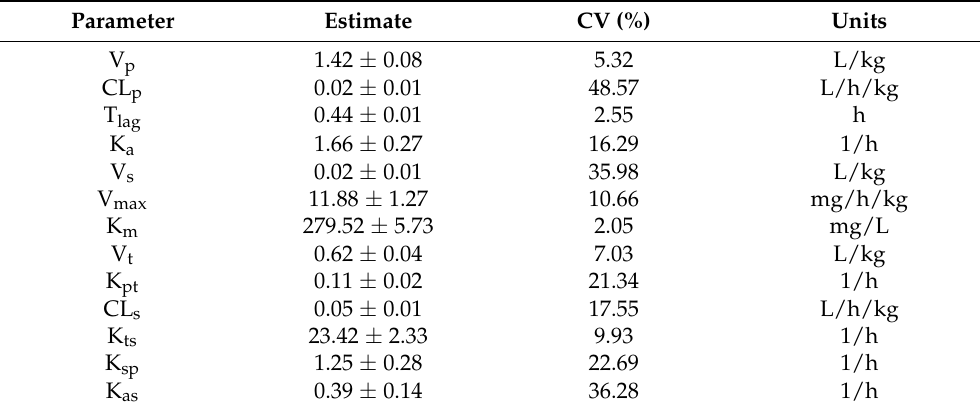
Table 6. List of the final PK parameters for population co-modeling of plasma and saliva concentration of matrine in human (Model C).